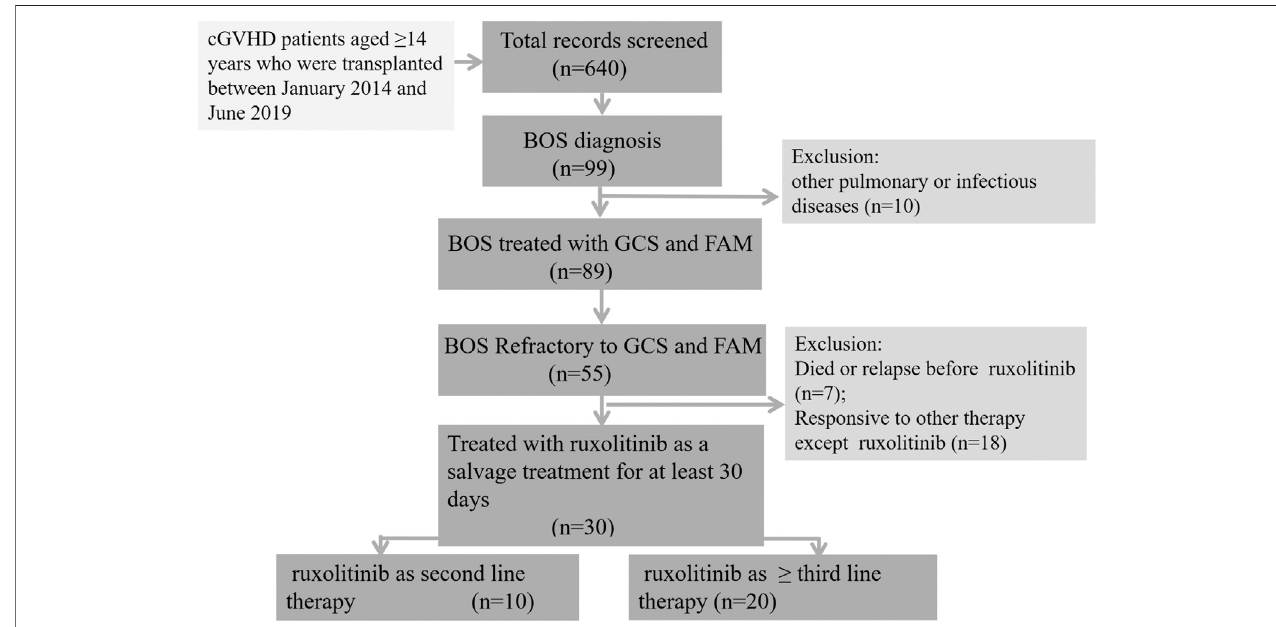
FIGURE 1 | Flow diagram of the study cohort. Eighty-nine patients were diagnosed with BOS related to cGVHD, not related to other pulmonary or infectious disease. Among these 89 patients, 30 patients who were refractory disease to fi rst-line glucocorticosteroids plus FAM and treated with ruxolitinib as ≥ second-line therapy, were retrospectively enrolled in this analysis. cGVHD, chronic graft versus host disease; BOS, bronchiolitis obliterans